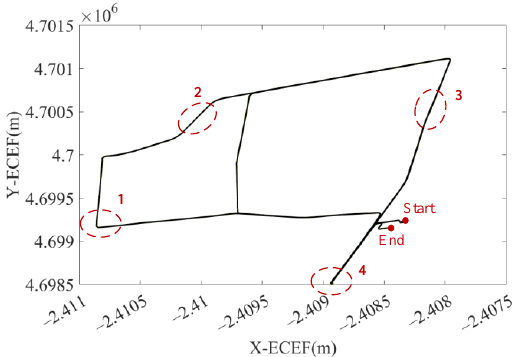
Figure 7. The reference trajectory of the GNSS available experiment in ECEF. The end and the start is marked in red point. Four sections are given detailed figures for further analysis (in dashed red circle)